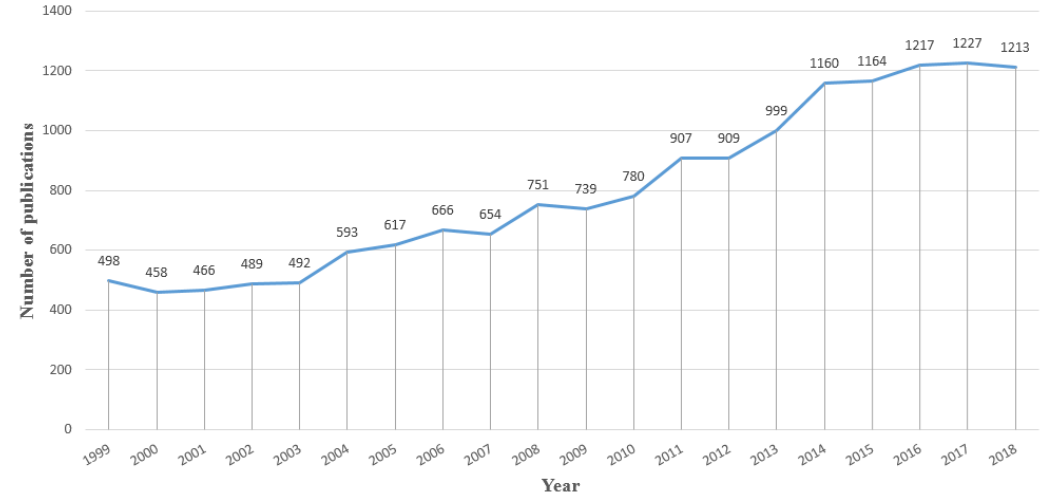
Figure 2. Global literature about air pollution and children published from 1999–2018.